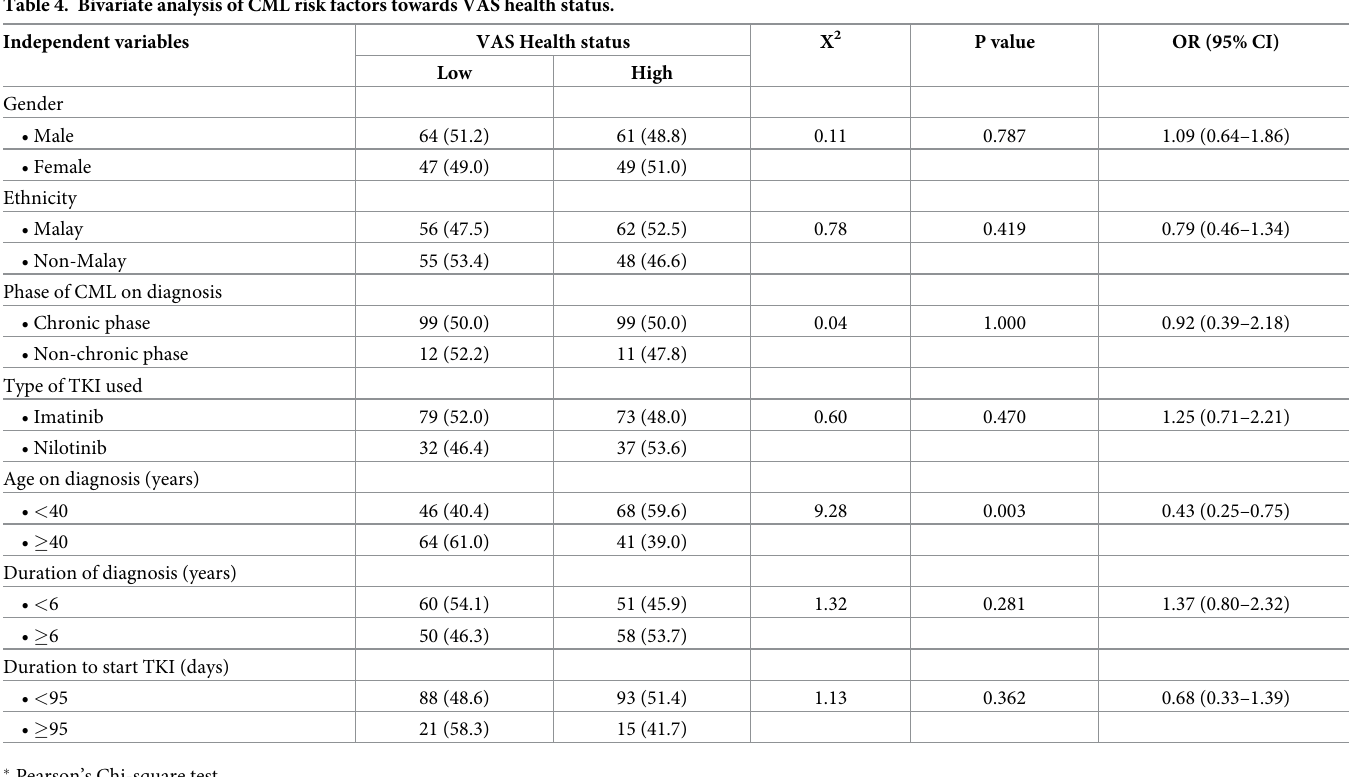
Table 4. Bivariate analysis of CML risk factors towards VAS health